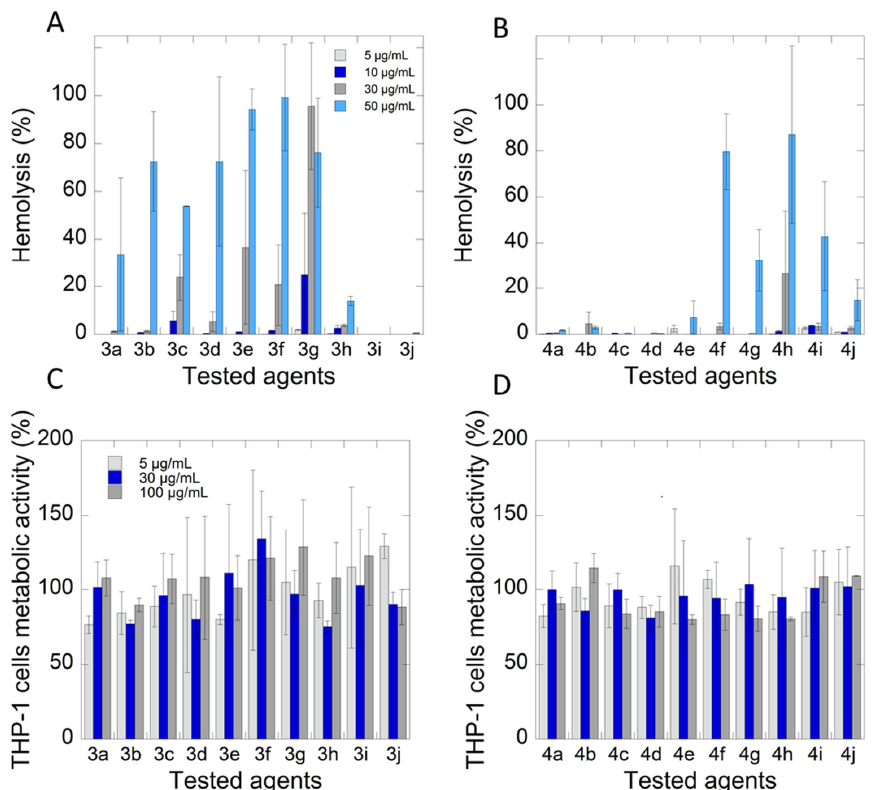
Figure 5. Hemocompatibility of synthesized salts. Hemolytic activity of synthesized salts 3a – j ( A ) and 4a – j ( B ). Metabolic activity of THP-1 cells after treatment by synthesized salts 3a – j ( C ) and 4a – j ( D ). The results are presented as the mean values ± SD.